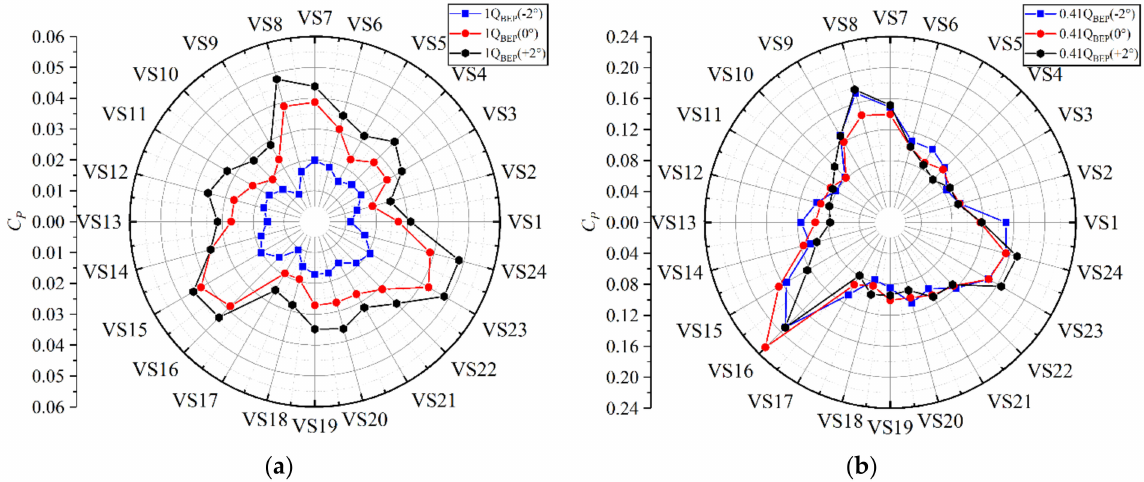
Figure 22. VS pressure pulsation distribution mode for three runner blade angles: ( a ) rated operating condition, ( b ) deep part-load operating condition.